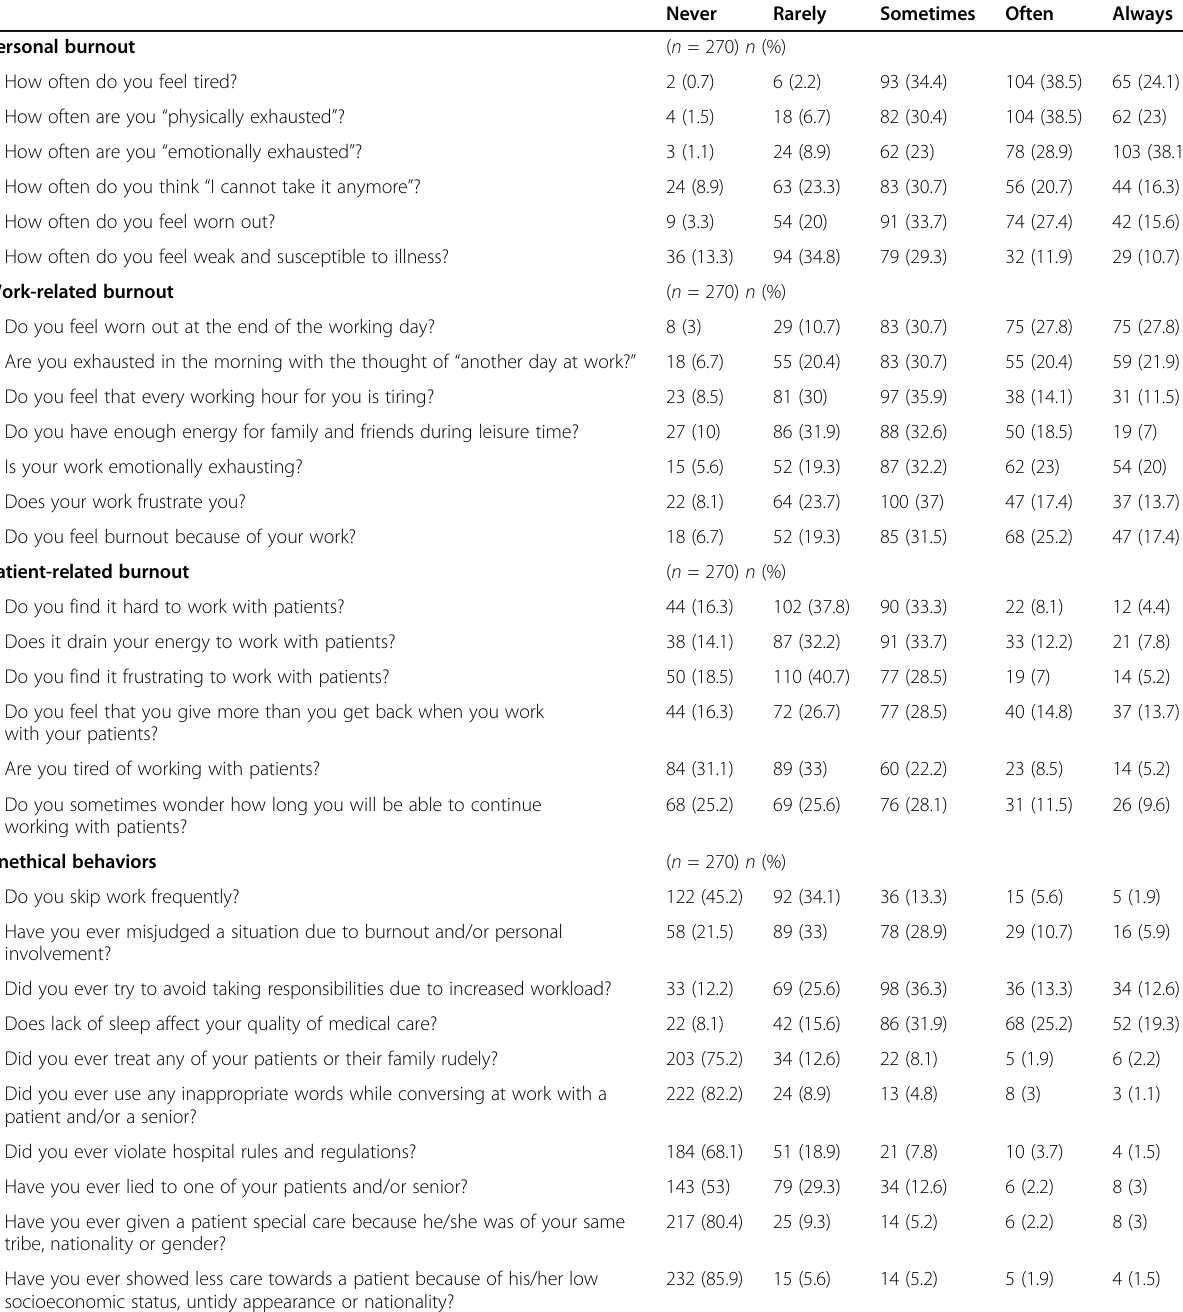
Table 3 Components of burnout and unethical behavior questionnaire